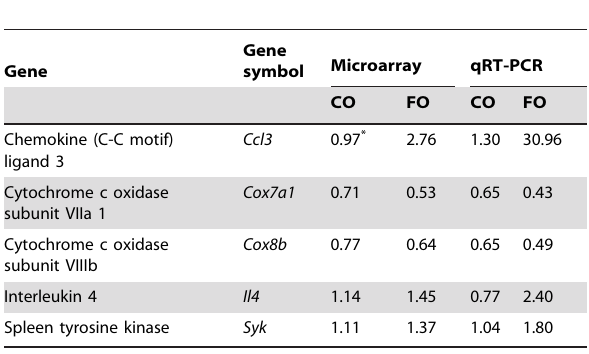
Table 6. GSEA pathways down-regulated in the FO group, as compared to CO